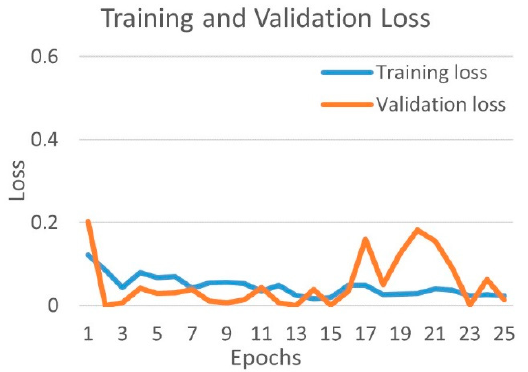
Figure 11. Training and validation loss of best performing DenseNet201 model for COVID-19 and bacterial pneumonia class.